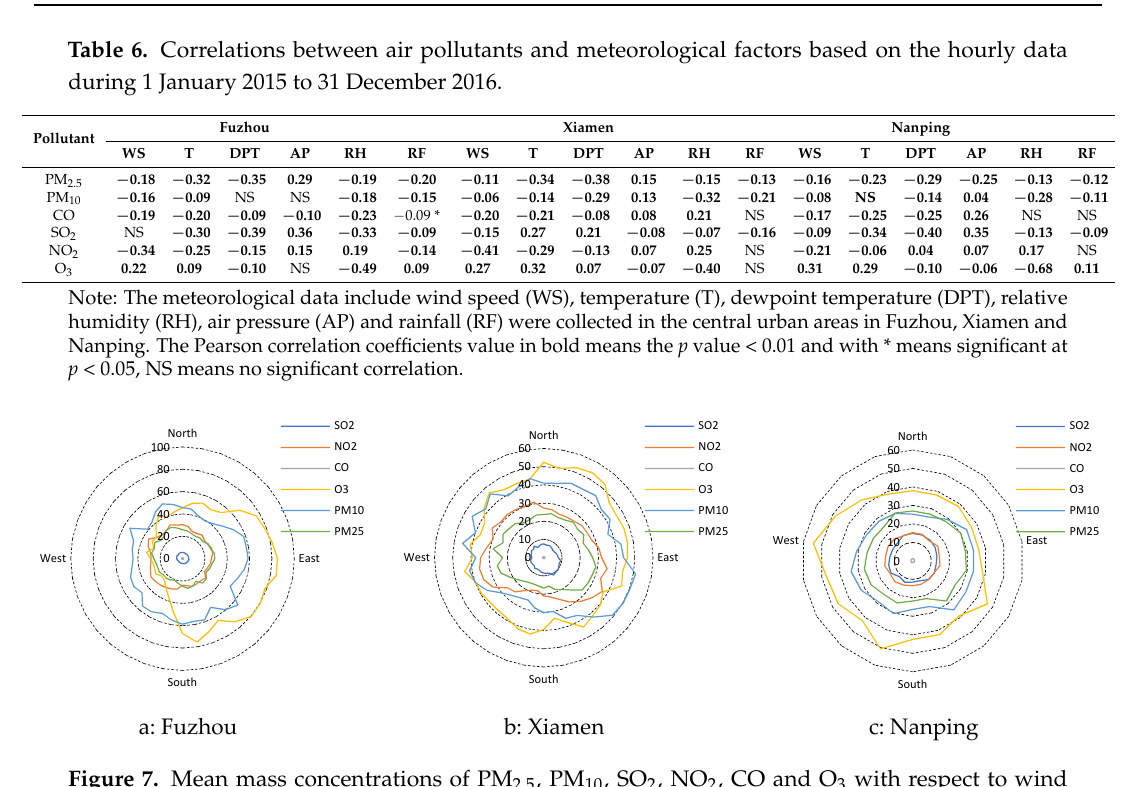
Table 6. Correlations between air pollutants and meteorological factors based on the hourly data during January 1 st 2015 to December 31 st 2016.